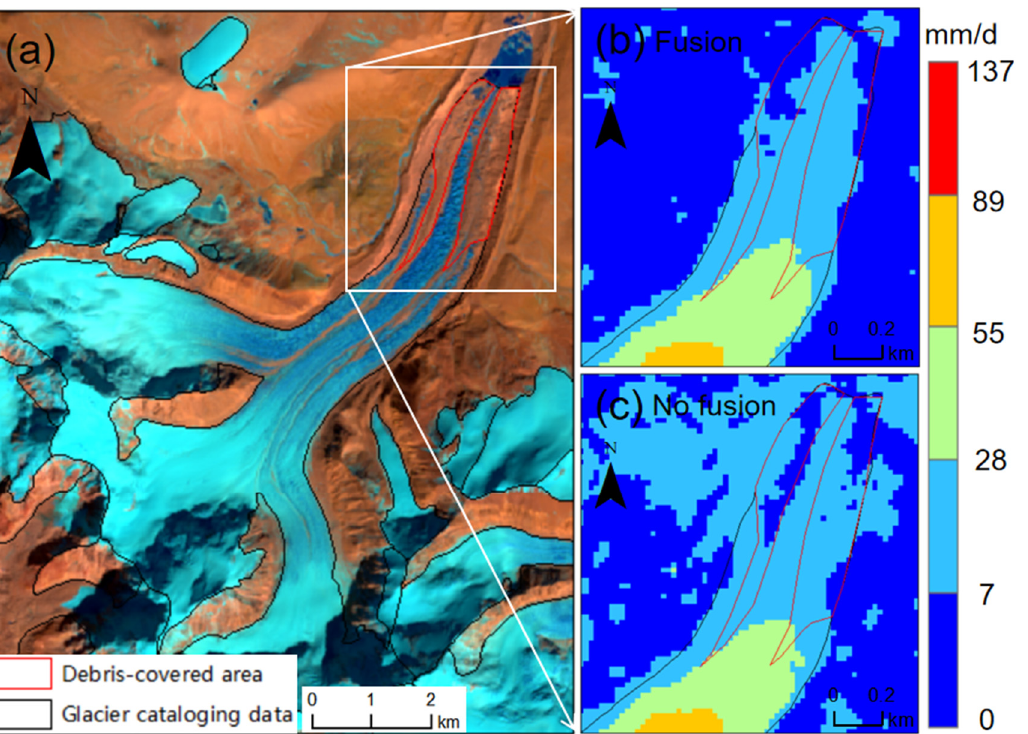
Figure 11. Comparison of glacier cataloging information and joint results in the study area. ( a ) Cataloging glacier data and mapping areas covered by moraines; ( b ) The fusion results are more consistent with the surface moraine glacier boundary; ( c ) The result without fusion was inconsistent with the surface moraine glacier boundary.